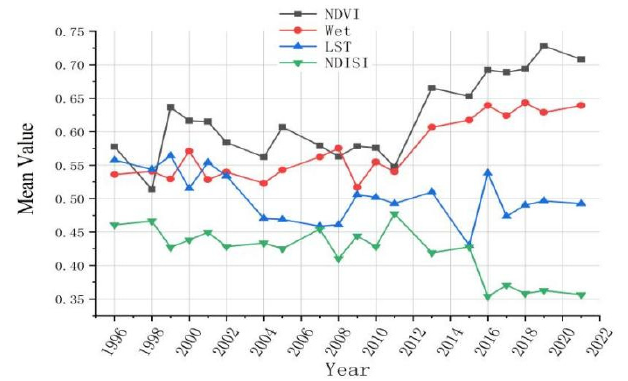
Figure 5. Trends of 4 indicators of RSEI. Among them, NDVI and Wet indicators were positively correlated with RSEI, and LST and NDSI were negatively correlated with RSEI.